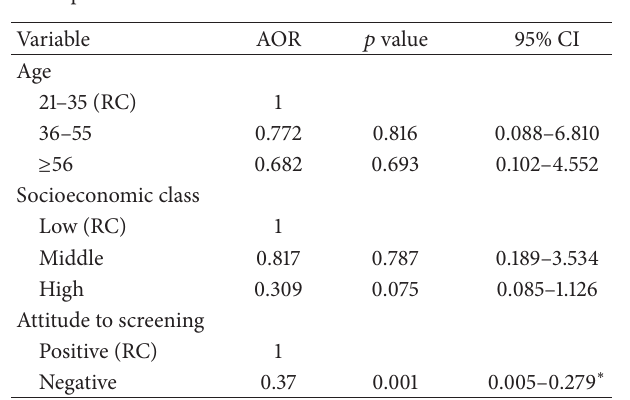
Table4:Determinantsofuptakeofcervicalcancerscreeningamong the respondents.